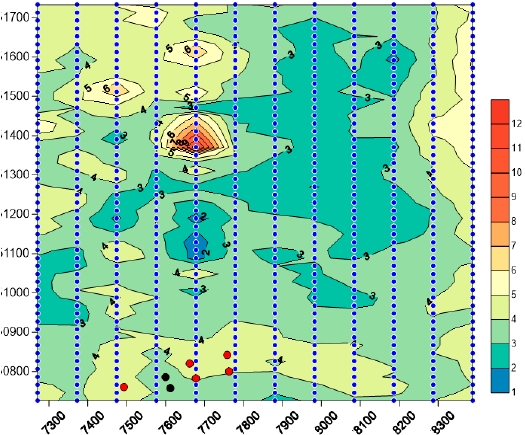
Figure 10. The minimum curvature interpolation contour map. The red and black symbols are the logging well with and without gold mine, respectively.